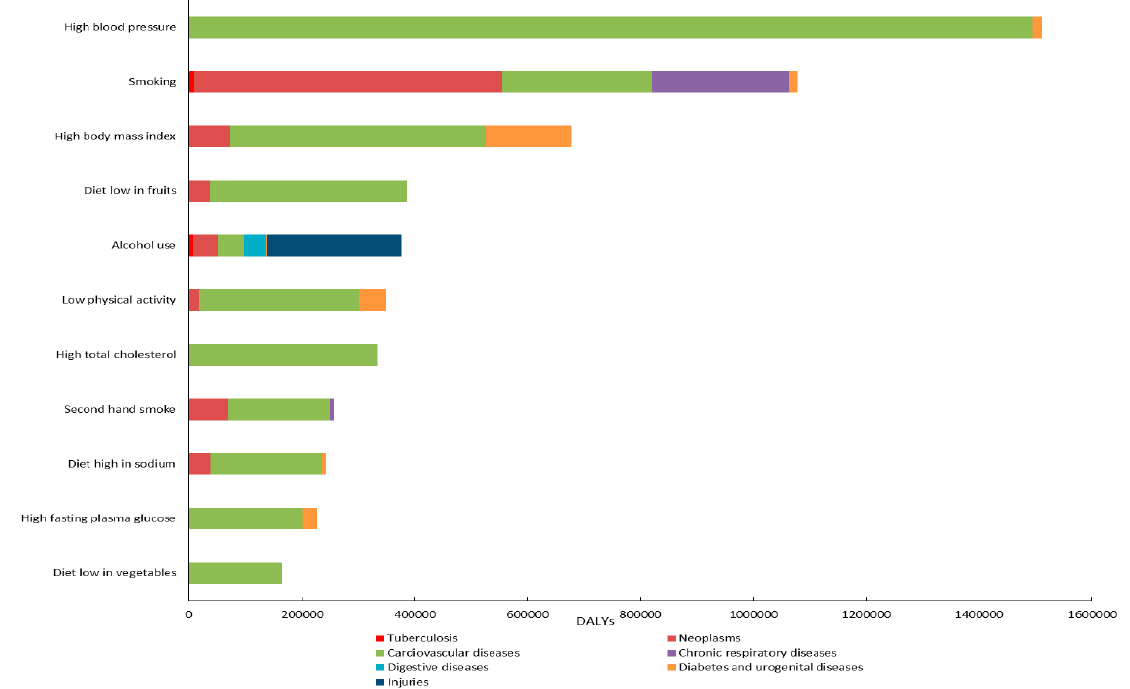
Figure 2. Main causes of DALYs attributed to each risk factor for both sexes in Hubei Province in 2013.